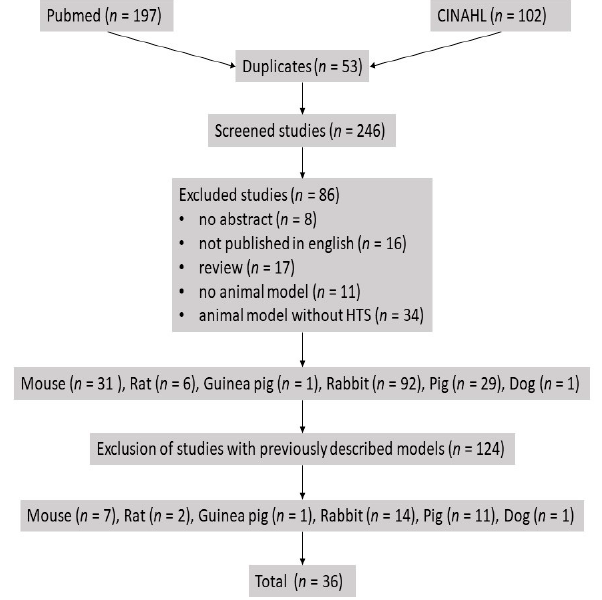
Figure 1. Flowchart. This flowchart shows the literature research procedure. 246 studies were screened, and after determination of exclusion criteria, a total of 36 studies were analyzed.